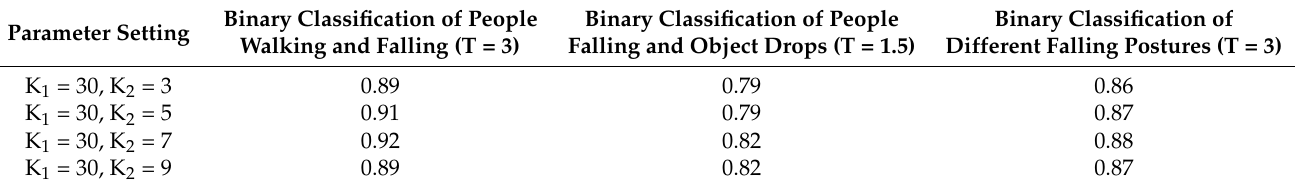
Table 2. Accuracy of classification with different K 2 values.